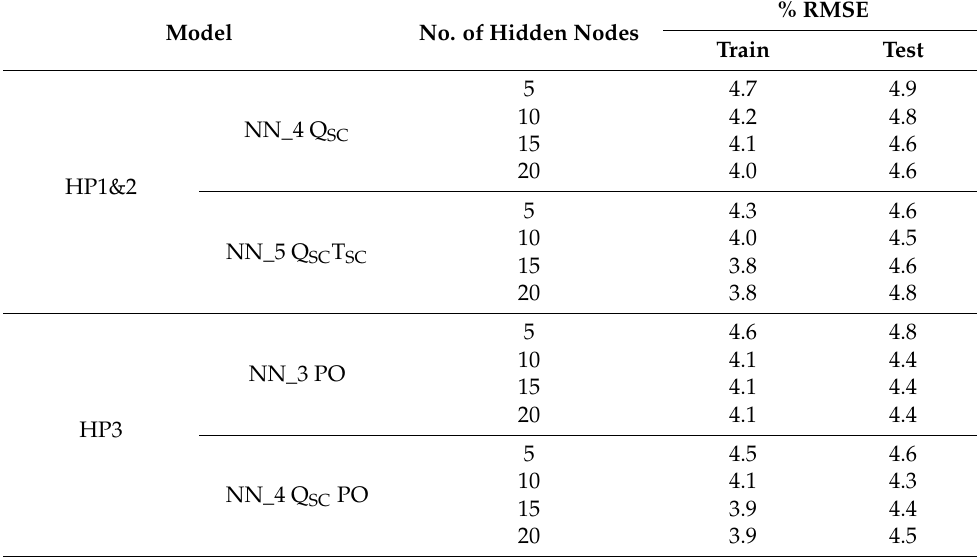
Table 10. Optimizing the number of hidden nodes.